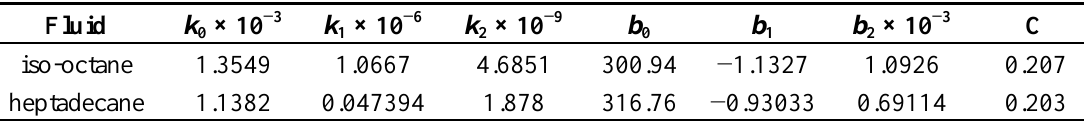
Table 2. Constants used in the Tait